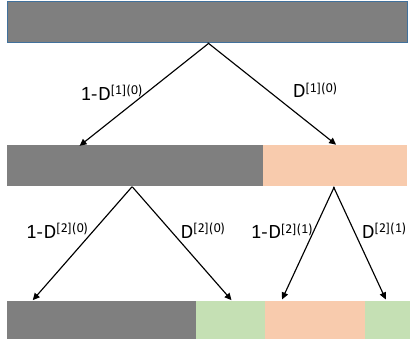
Figure 4. Schematic representation of the composite material after two healing events, which consists of the original material that has not been damaged by either of the two loading cycles, the material that is created after the first healing event and has not been damaged in the second loading cycle, and the material that is created in the second round of healing events and accounts for the damage in both the original material and in the material created by the first healing